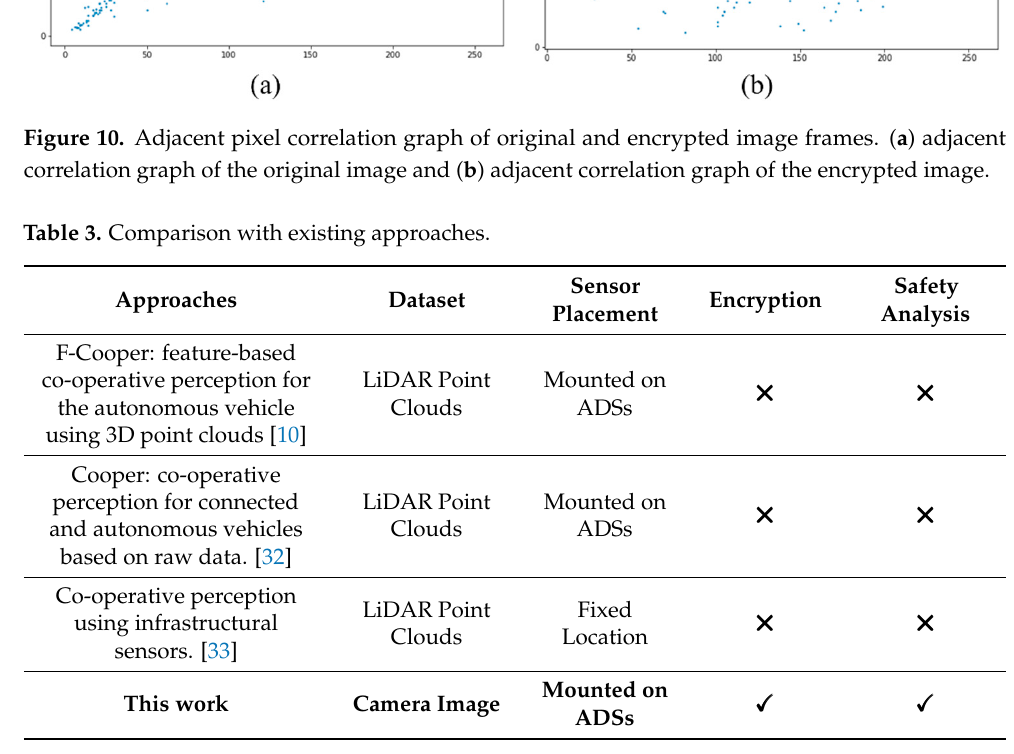
Figure 10. Adjacent pixel correlation graph of original and encrypted image frames. ( a ) adjacent correlation graph of the original image and ( b ) adjacent correlation graph of the encrypted image.